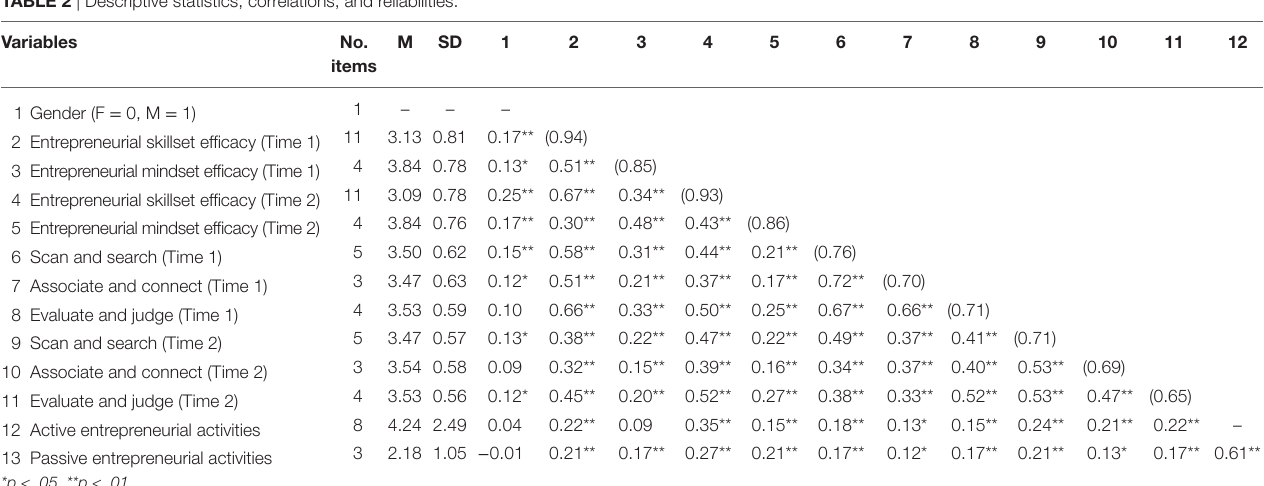
Table 2 | Descriptive statistics, correlations, and